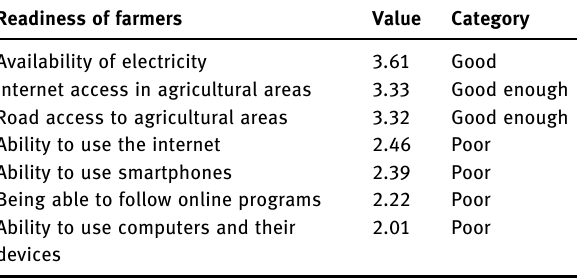
Table 5: Farmers ’ level of readiness regarding support for the use of SFT